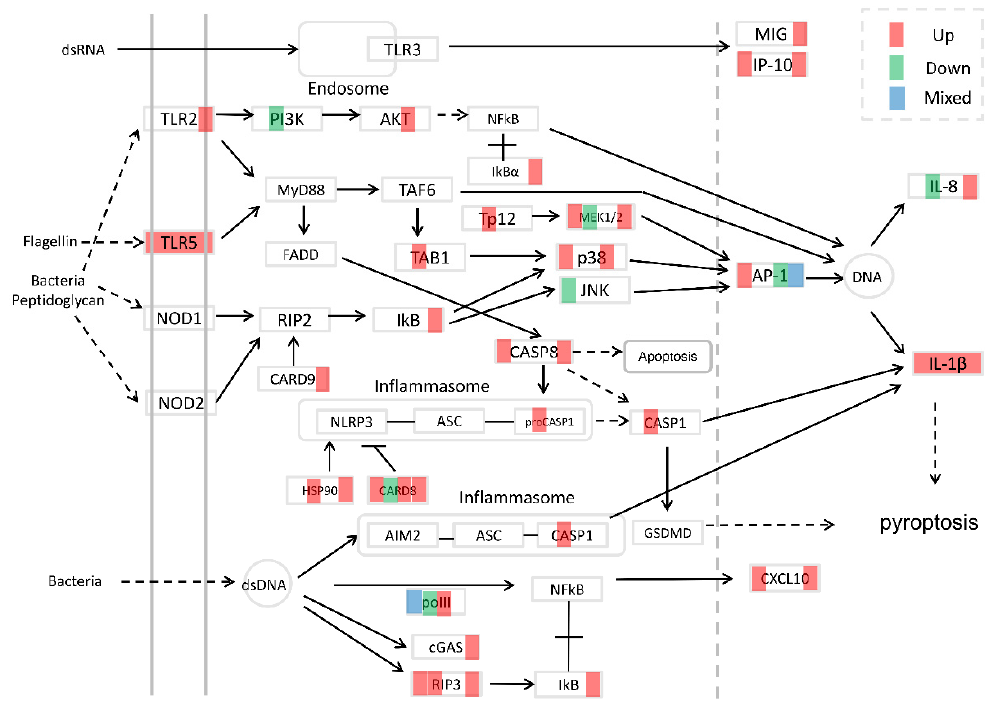
Figure 5. The integrated graph of DEGs changes included in the Toll-like receptor signaling pathway, the NOD-like receptor signaling pathway, and the cytosolic DNA-sensing pathway in four comparisons (B6h vs. P6h, B9h vs. P9h, B15h vs. P15h, and B18h vs. P18h). The rectangles of putative protein were equally divided into four parts from left to right, corresponding to four comparisons. Red, green, and blue colors, respectively, represent up, down, and mixed regulation.